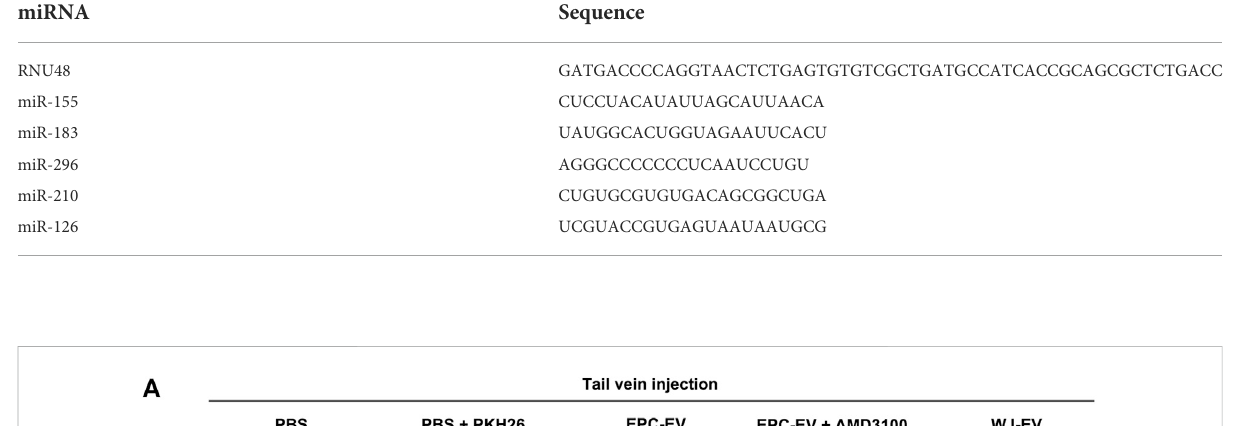
TABLE 2 Primers used for quantitative polymerase chain reaction of miRNA.